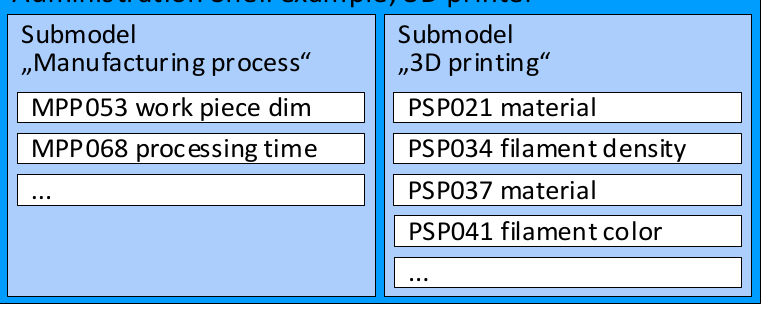
Figure 2. The bidding process related to specific submodels of the AAS.